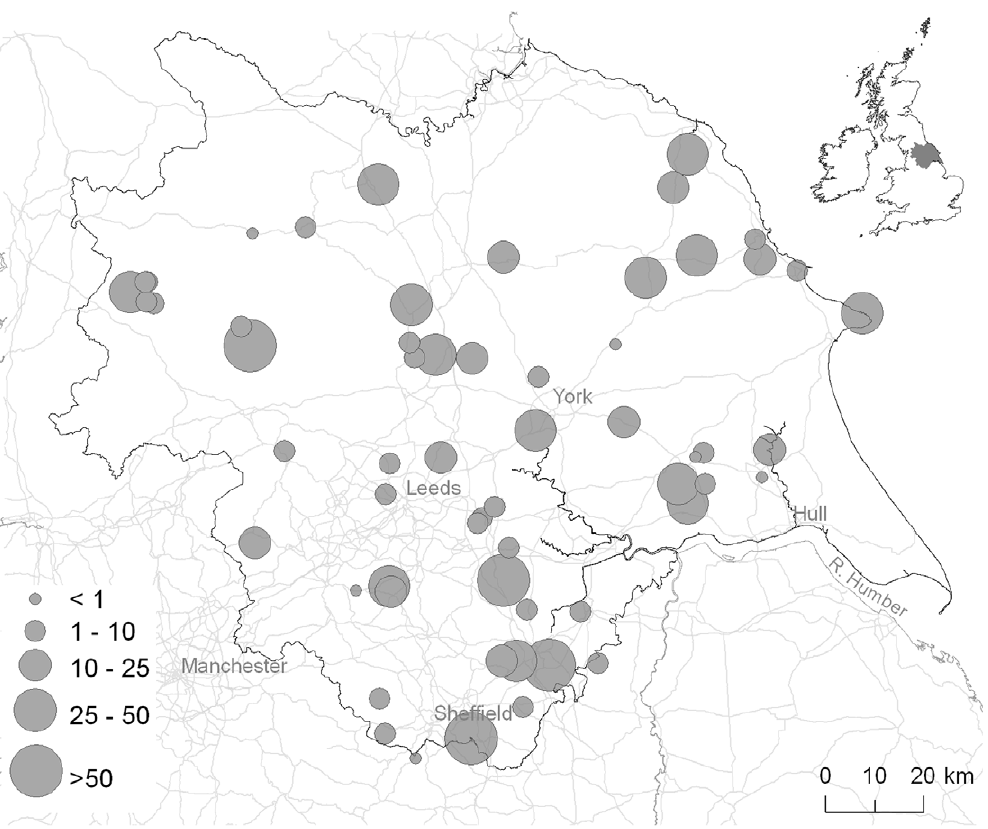
Figure 1. Yorkshire Wildlife Trust protected areas in Yorkshire, UK (inset). The size of circles provides an indication of site area on a categorical scale ( , 1, 1–10, 10–25, 25–50, . 50 ha) that is only used for illustration purposes in this figure - all analyses treat site area as a continuous variable.